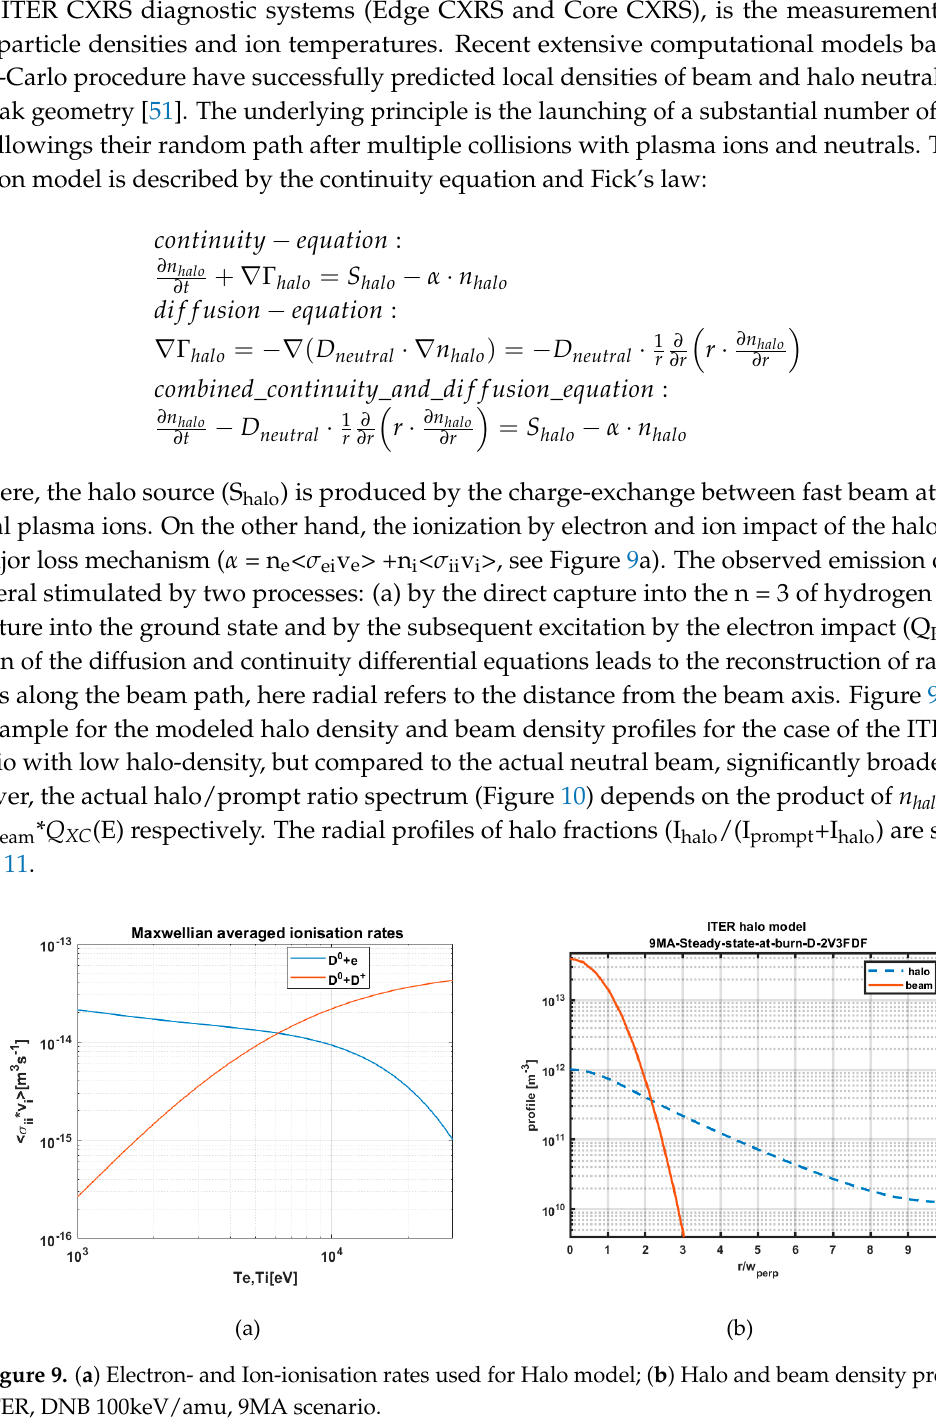
Figure 10. ( a ) Prompt HeII CX spectrum, synthetic line of sighted integrated halo spectrum and Gaussian prompt spectrum normalized to halo amplitude. Ratio I halo /(I prompt +I halo ) = 0.07for the 9 MA- steady-state-at-burn scenario; ( b ) Prompt HeII CX spectrum, synthetic line of sighted integrated halo spectrum and Gaussian prompt spectrum normalized to halo amplitude Ratio I halo /(I prompt +I halo ) = 0.16. for the 15 MA flat density scenario